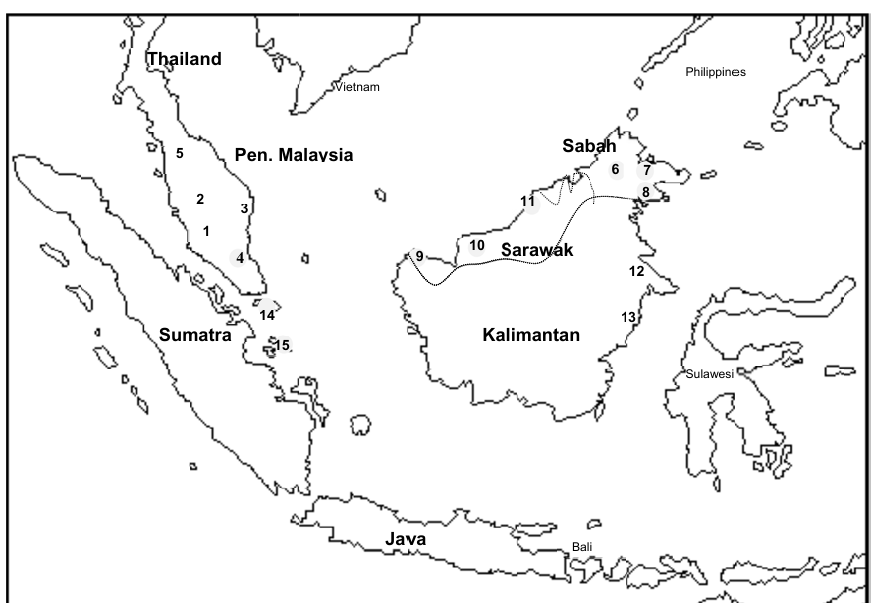
Fig 2. Main sampling sites of